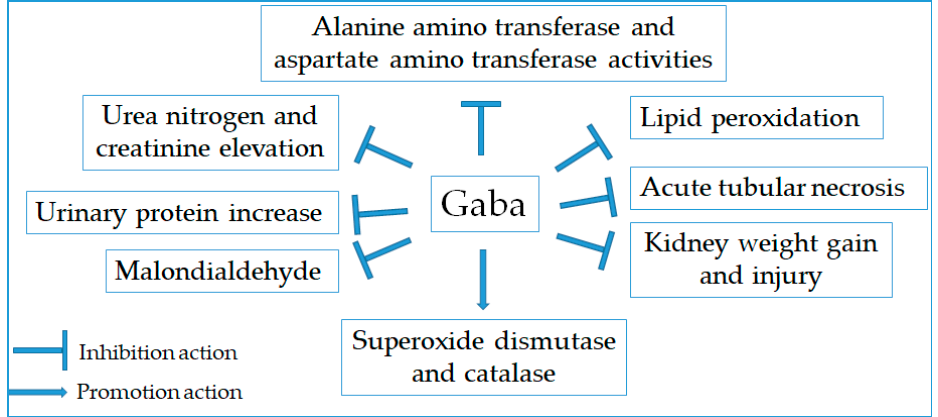
Figure 8. Mechanism of the action of Gaba for renoprotection.